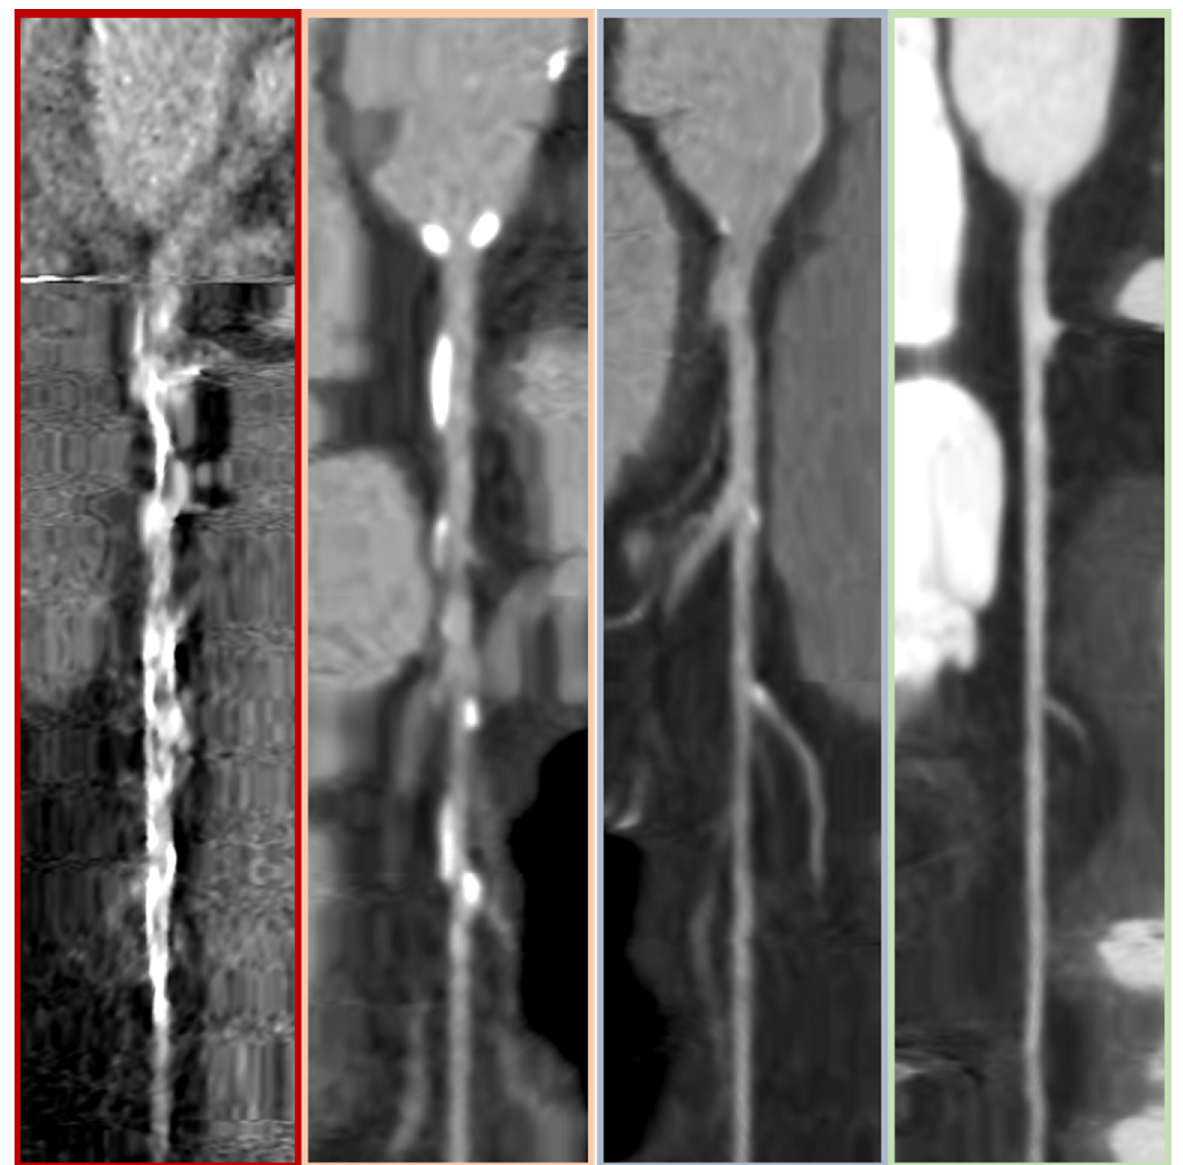
Figure 2. CCTA quality criteria. Examples of CCTA imaging for each quality score category, from left to right, from 0 to 3.